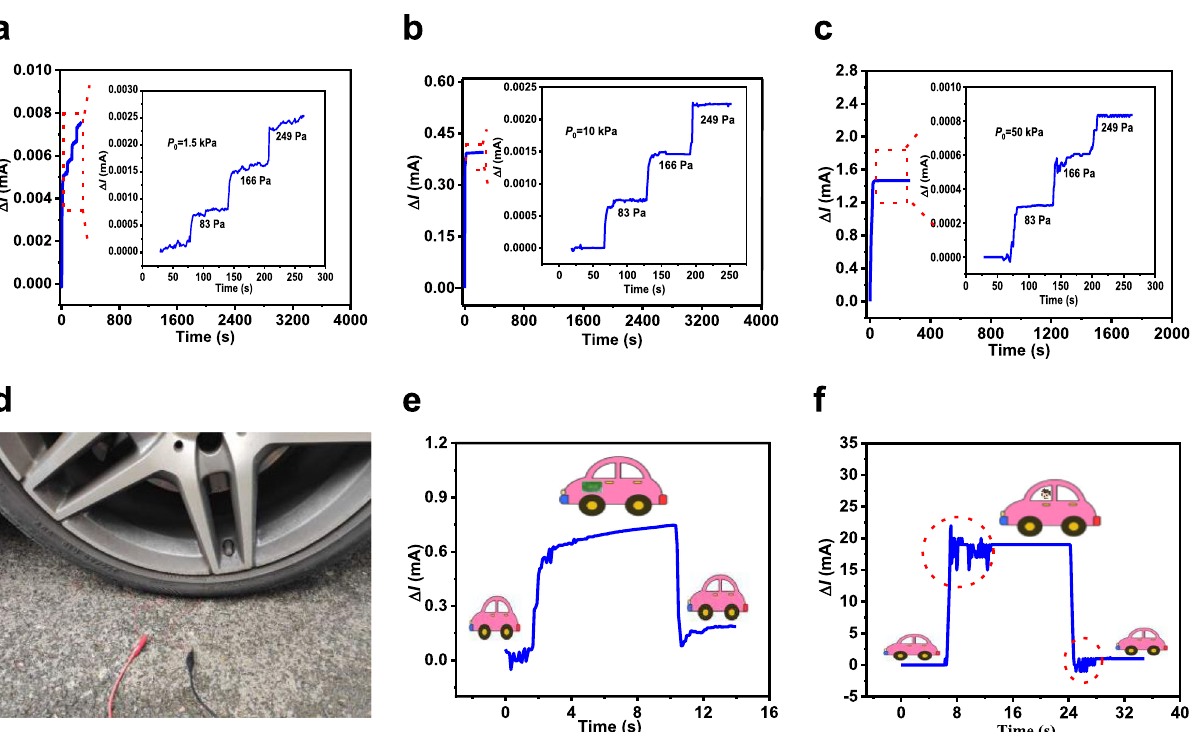
Fig. 5 Extremely high-sensing resolution of the Fe 2 O 3 /C@SnO 2 pressure sensor. Detection of micro pressure under loading pressures of a 1.5 kPa, b 10 kPa, and c 50 kPa. d Experimental setup of a car with a Fe 2 O 3 /C@SnO 2 (3:1:4) pressure sensor attached under a front tire. e Current signals corresponding to an unloaded, loaded, and unloaded 4 kg carton of milk on the driving seat of the car. f Current signals corresponding to a 73 kg male passenger getting into and out of the to monitor the occlusion movements of humans, as displayed in Fig. 6c. Upon occlusion, the current was found to have sig-